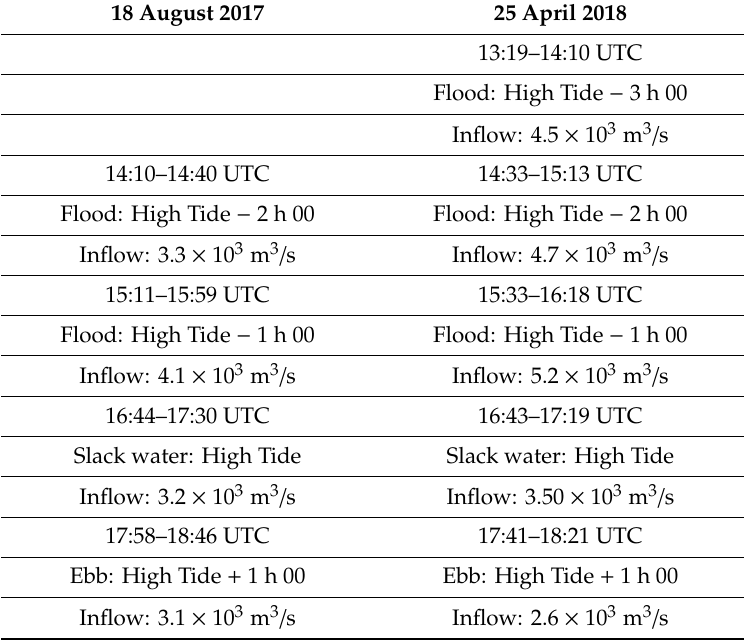
Table 2. Date, time, and inflow in the first 50 m of the water column for the ADCP cross-bay sections performed in winter (August 2017), and Autumn (April 2018)